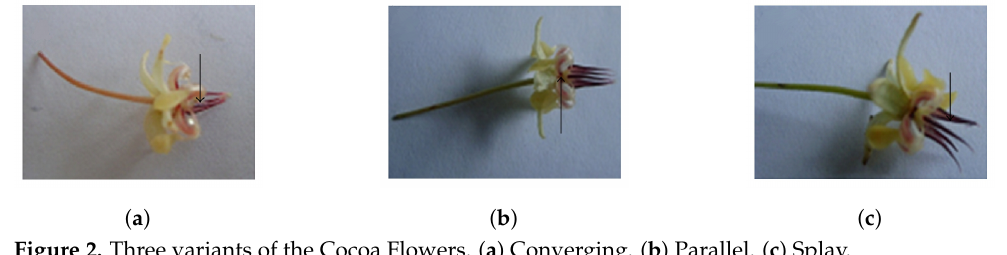
Figure 2. Three variants of the Cocoa Flowers. ( a ) Converging. ( b ) Parallel. ( c )